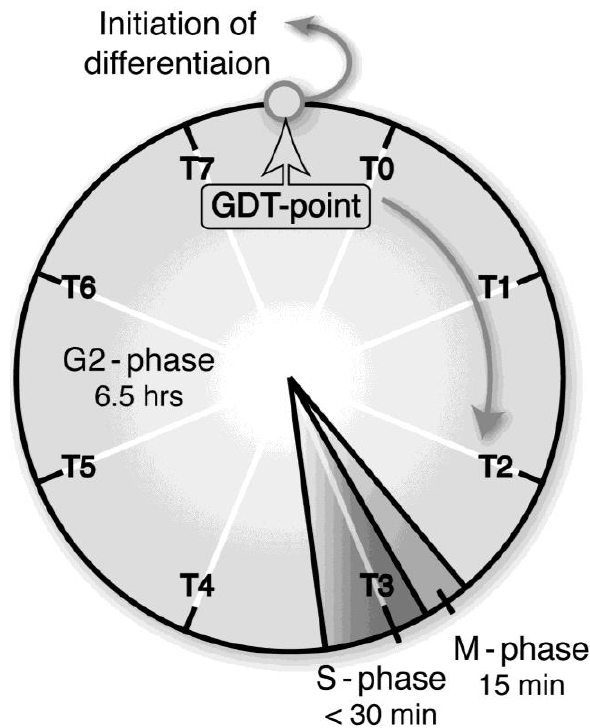
Figure 2. A growth/differentiation checkpoint (GDT point) in the cell cycle of a Dictyostelium discoideum Ax-2 cell. The doubling time of axenically growing Ax-2 cells is about 7.2 h and most of their cell cycle is composed of G2-phase with little or no G1-phase and a short period of M- and S-phases. A specific checkpoint (referred to as the GDT point) of GDT is located at the mid–late G2-phase (just after T7 and just before T0). Ax-2 cells progress through their cell cycle to the GDT point, irrespective of the presence or absence of nutrients, and enter the differentiation phase from this point under starvation conditions [2]. T0, T1, and T7 indicates 0, 1, and 7 h, respectively, after a temperature shift from 11.5 °C to 22.0 °C for cell synchrony. The absence of G1 phase in the Dictyostelium cell cycle is not so strange, because there is little or no G1 phase in rapidly dividing cells such as animal cells at the cleavage stage, and also in the true slime mold Physalum and Hydra . (Basically from Maeda